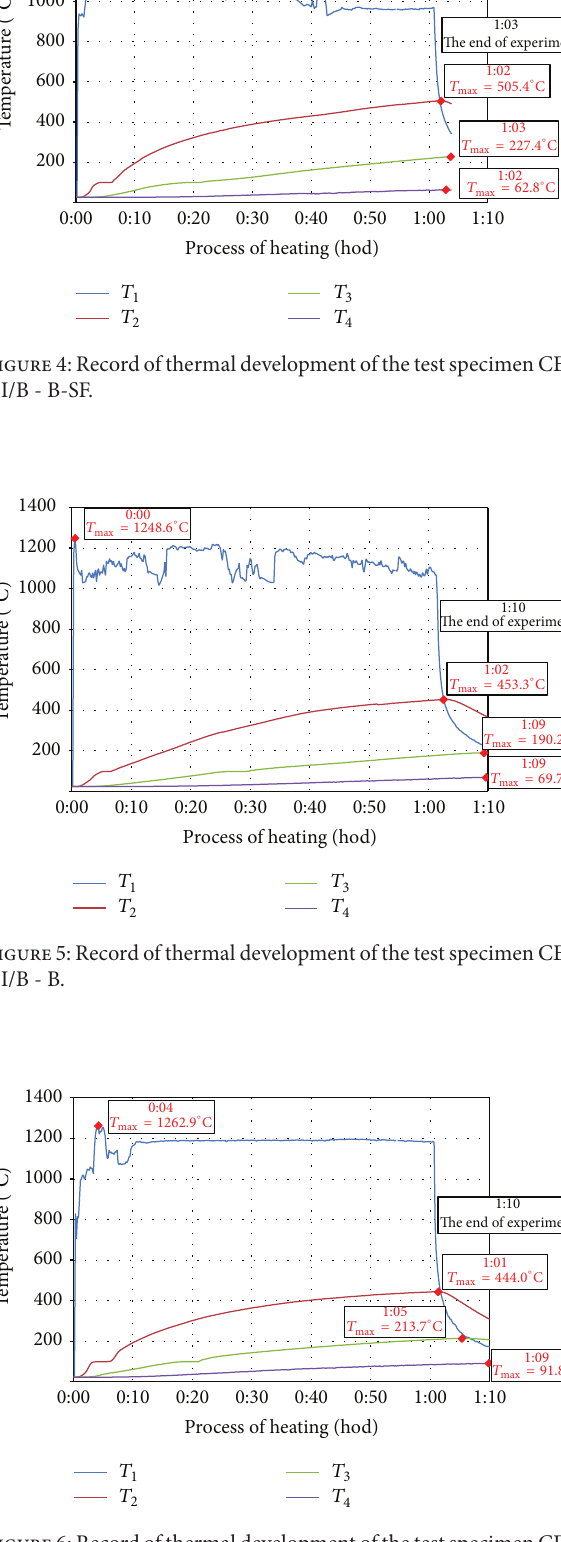
Figure 6: Record of thermal development of the test specimen CEM I - GR-SCC.